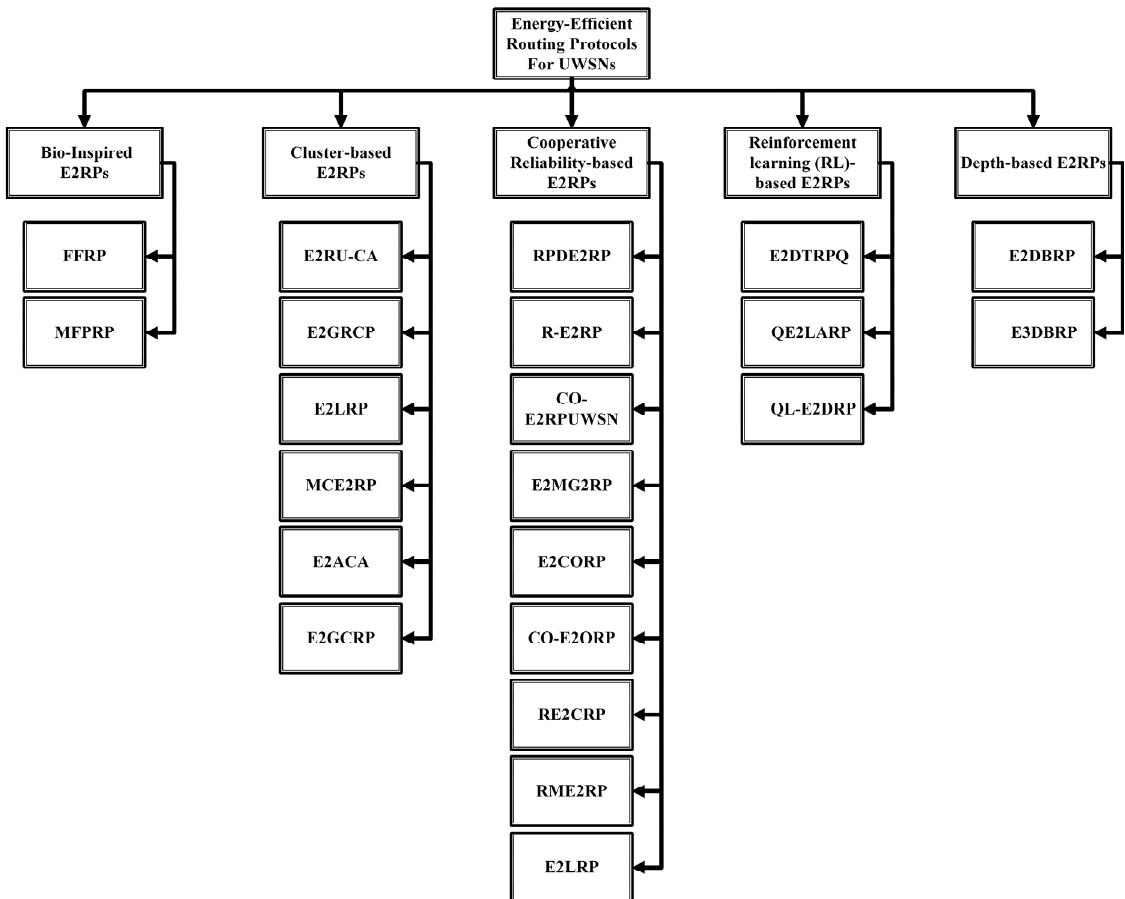
Figure 12. Classification of energy ‐ efficient routing protocols.